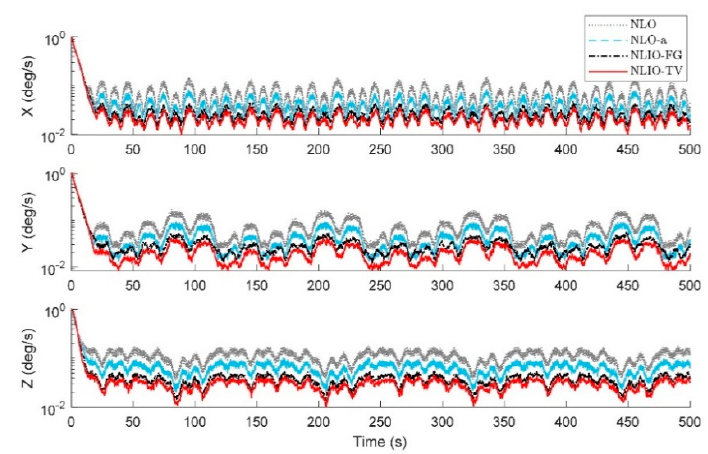
Figure 7. Averaged absolute attitude estimation error over 100 simulations for Case 2.